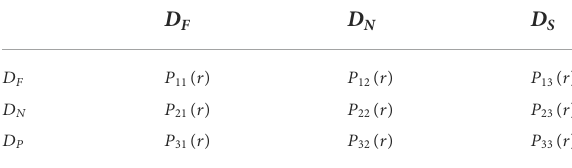
TABLE 1 Consumer demand